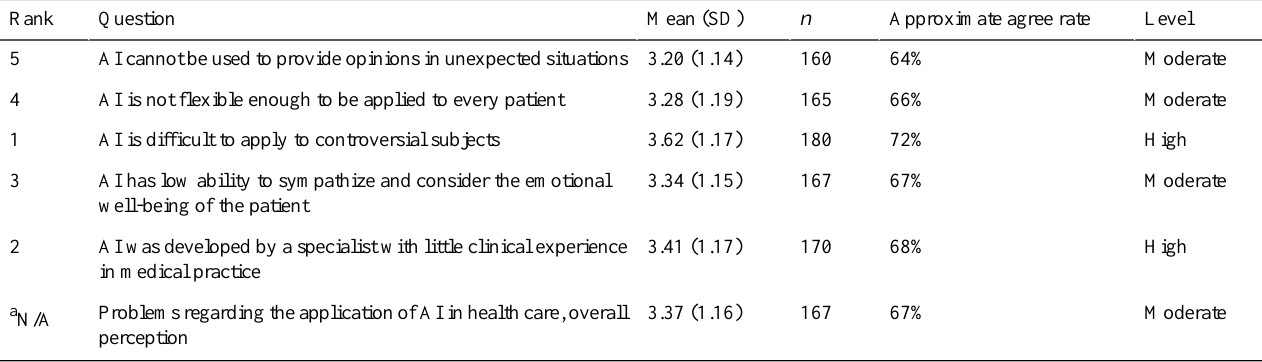
Table 5. The application of AI in health care